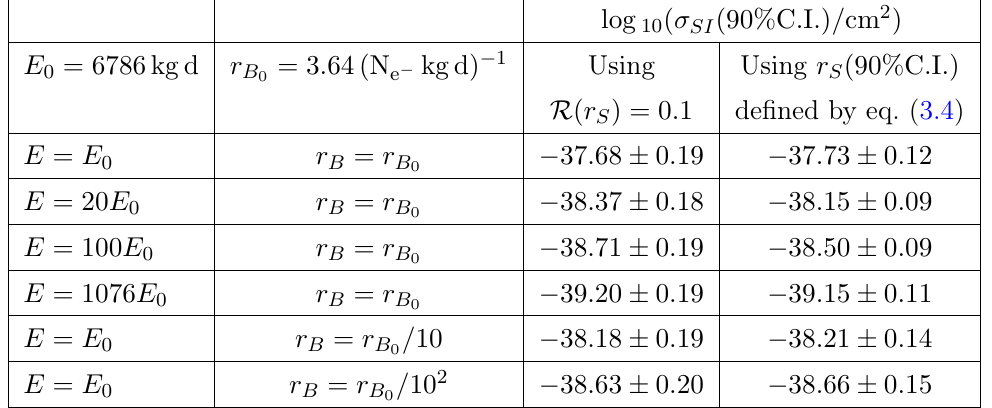
in this region S